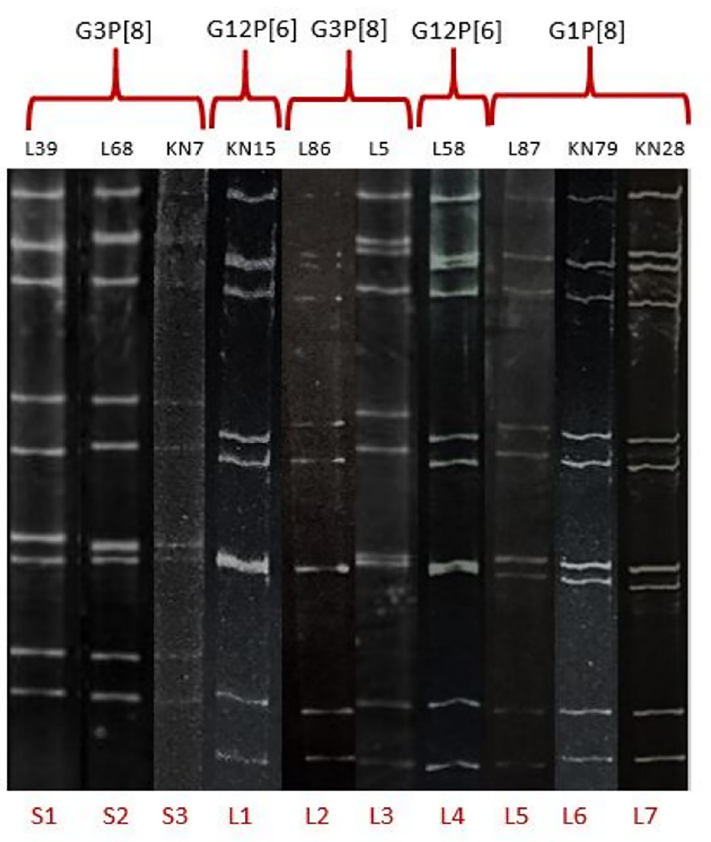
Fig 2. Electropherotypes of rotaviruses identified in Sabah. In total, 11 electropherotypes were identified, three short (S1–S3) and eight long (L1–L8) electropherotype patterns were identified. The strain number and genotype of each electropherotype is shown above the